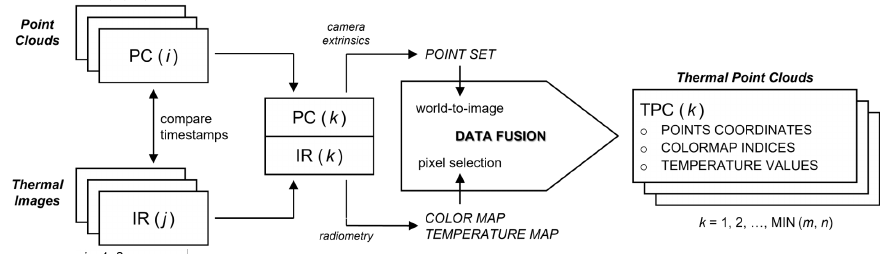
Figure 4. Overview of the data fusion procedure. The algorithm takes a sequence of 3D point clouds and thermal images as input, returning a set of 3D thermal point clouds as output. First, the timestamp of each point cloud PC ( i ) is compared with the timestamp of each thermal image IR ( j ) to extract a sequence { PC ( k ) , IR ( k ) } of time-paired couples. The data fusion itself consists in converting the world coordinates of each point in PC ( i ) to image coordinates, and using those coordinates to select a single pixel from the color map and the temperature map extracted from IR ( k ) . This produces a sequence of thermal point clouds TPC ( k ) in which each element is characterized not only by its world coordinates but also by a color and a temperature